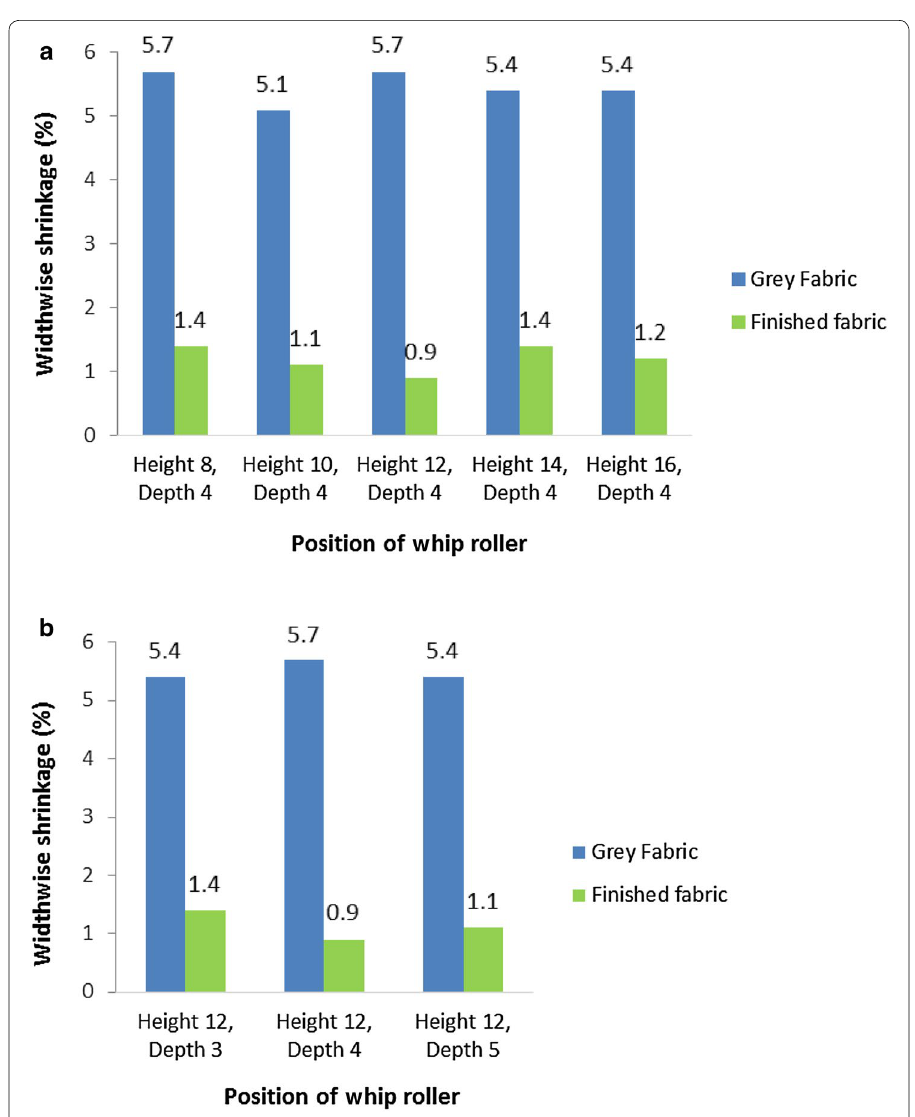
Fig. 12 a Width wise shrinkage (%) at variable height and constant depth of whip roller. b Width wise shrink- age (%) at constant height and variable depth of whip